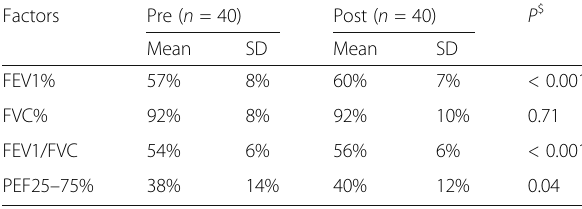
Table 2 Impact of bronchodilator in spirometry parameters Factors Pre ( n = 40) Post ( n = 40)